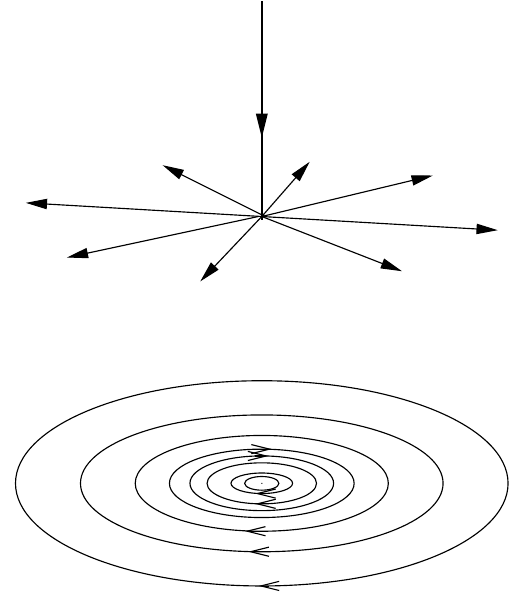
Fig. 1. The curl-free CECS (upper) and the divergence-free CECS (lower).